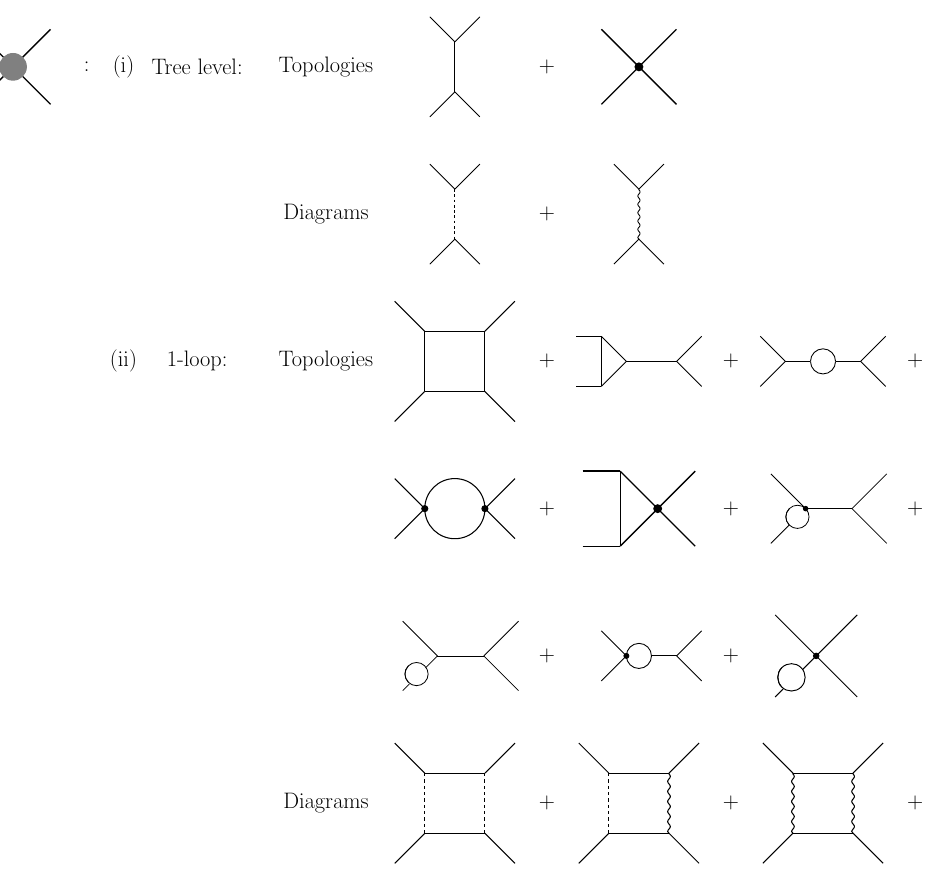
Figure 1. The figure illustrates the first two steps in the diagrammatic method for the construction of UV model lists. 4-point vertices are marked with a dot. For a discussion see